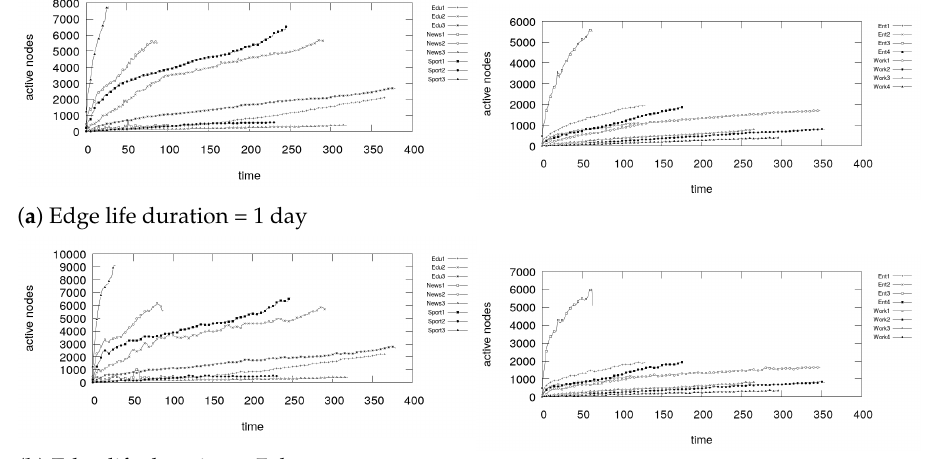
Figure 13. Number of active nodes detected by